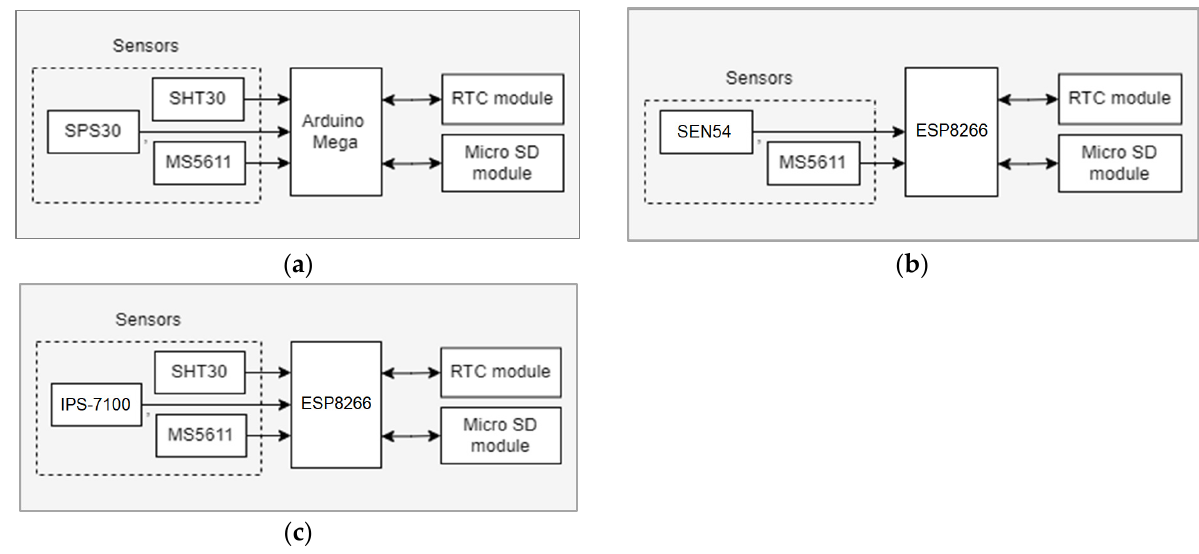
Figure 4. Block diagram of the PM measurement systems used for ( a – c ) urban and rural measurements.